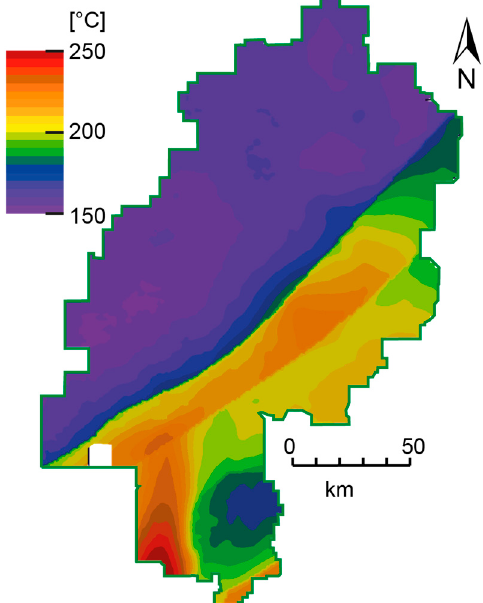
Figure 4. Dirichlet boundary condition at the bottom at a 6 km depth (simulated temperatures after Freymark et al. [8]).